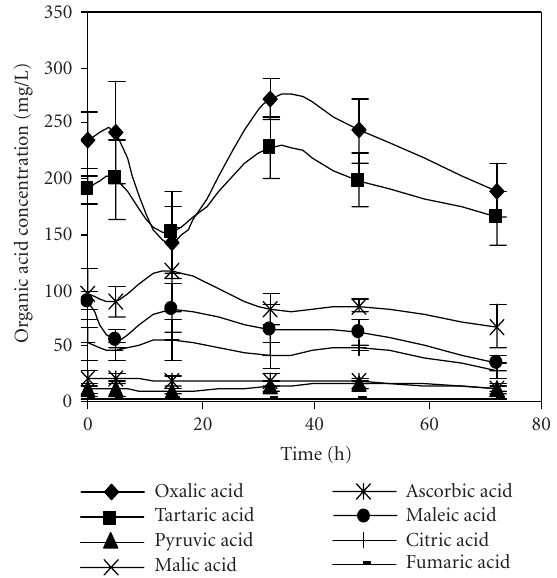
Figure 4. Evolution of concentration of organic acids present in the pomegranate juice obtained by squeezing of fruit halves with an electric lemon squeezer and stored for 72 hours at 4 ◦ C. Bars represent standard deviation of 4